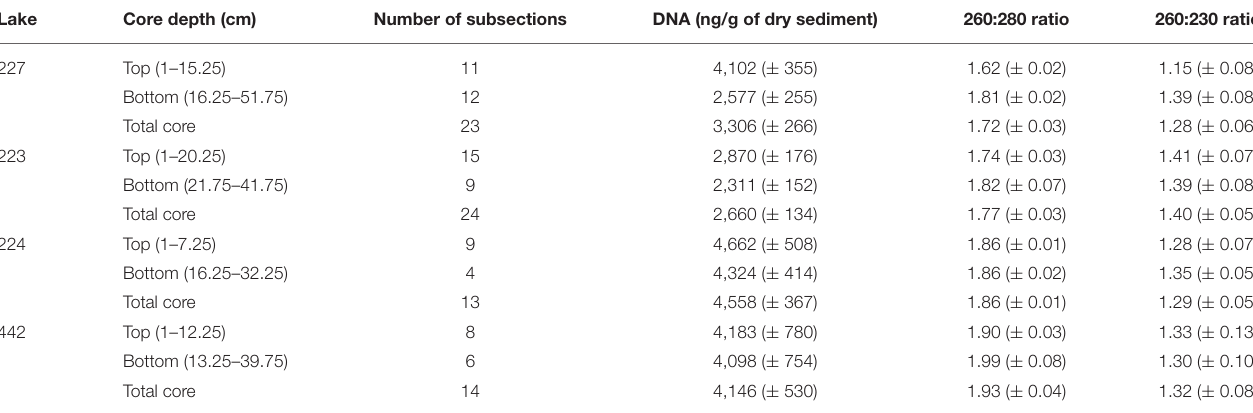
TABLE 2 | Comparison of mean DNA concentration ( ± SE ) and purity between top and bottom subsection intervals.